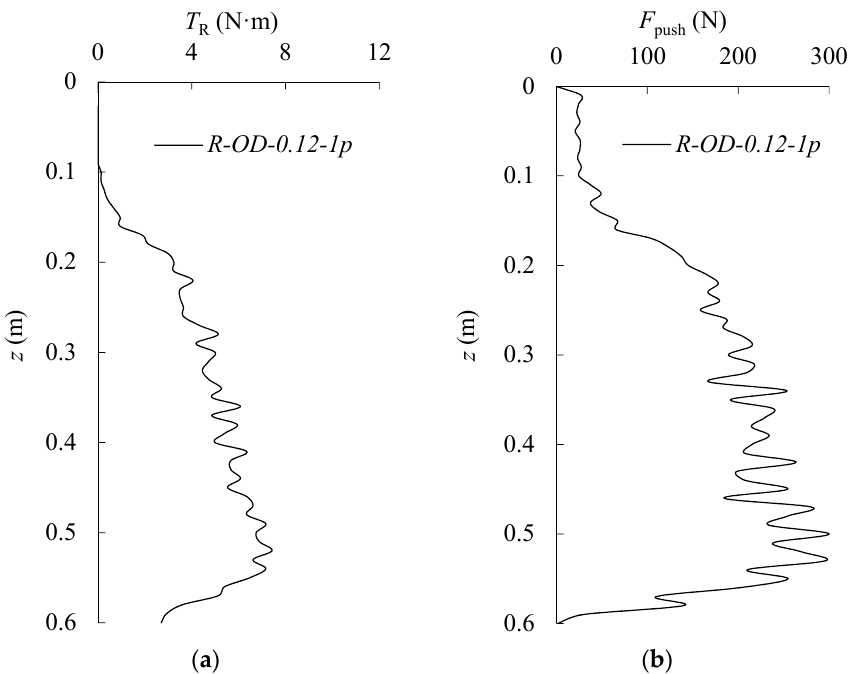
Figure 6. The test results of test number one (TN-1). ( a ) Recycling torque. ( b ) Vertical force on shaft. Appl. Sci. 2019 , 9 , x FOR PEER REVIEW